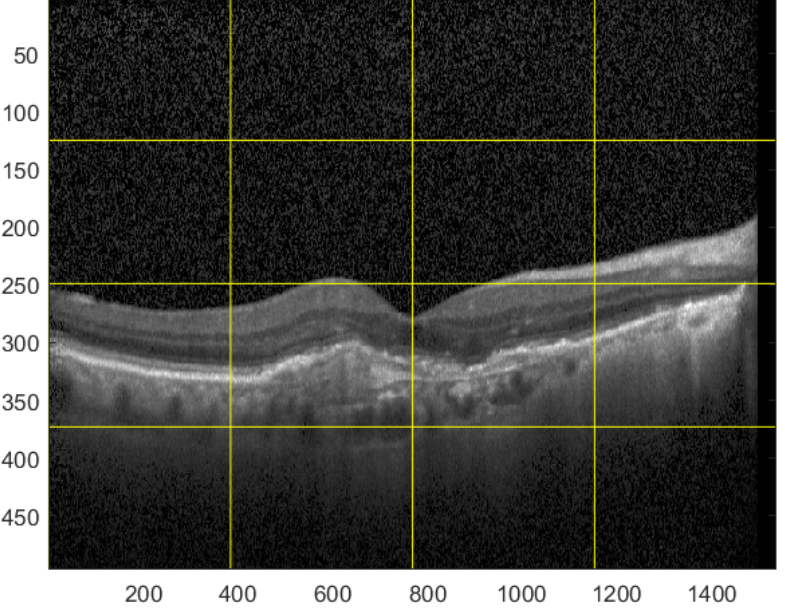
Figure 6. Blocks for which EHD descriptor is calculated.